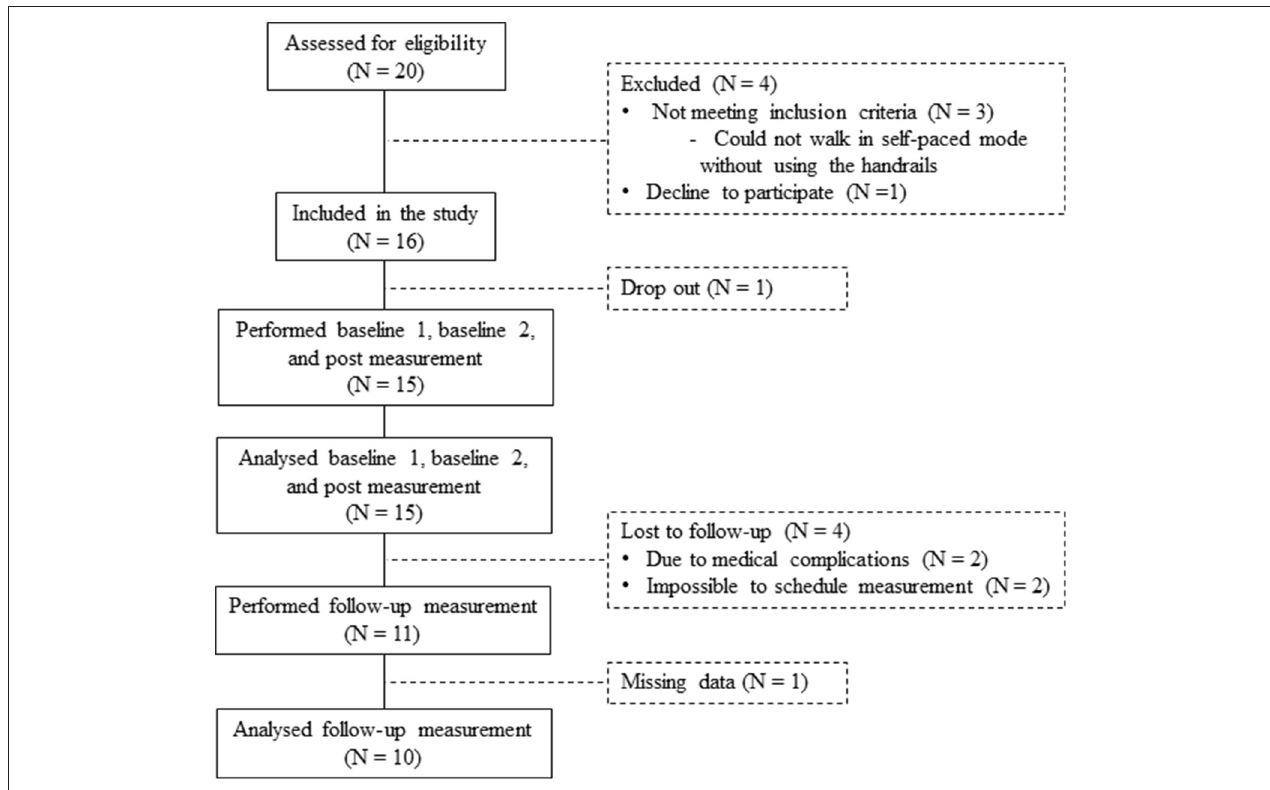
FIGURE 5 | Flow diagram of patients in the